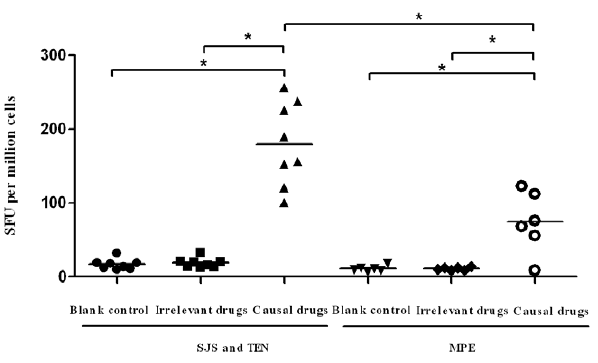
Figure 2. Ex vivo IFN- c ELISPOT responses to causal drugs. Purified PBMC (1 6 10 5 in 100 m L ) from patients with SJS and TEN or MPE were stimulated for 24 h with causal drugs, irrelevant drugs or medium alone in 96-well ELISpot plate. Responses are presented as number of IFN- c -positive spot-forming units (SFU) per million cells. Each data point represents an individual patient with SJS and TEN or MPE. Median is indicated by a horizontal line. * P ,